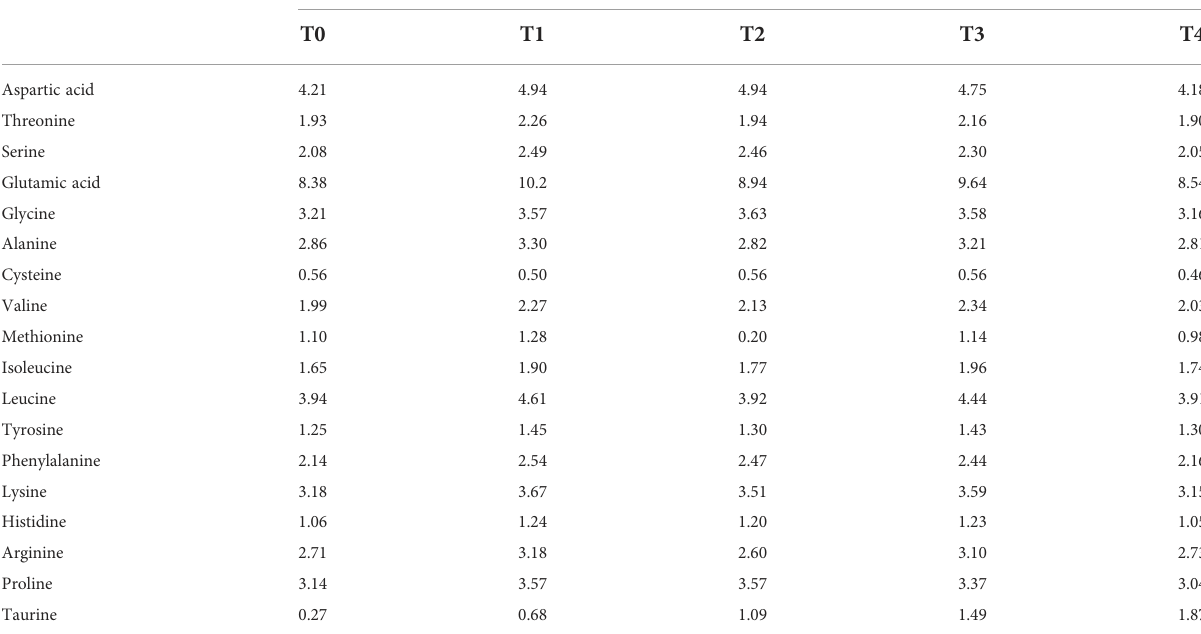
TABLE 2 Amino acid composition of the experimental diets(g·100g − 1 ).